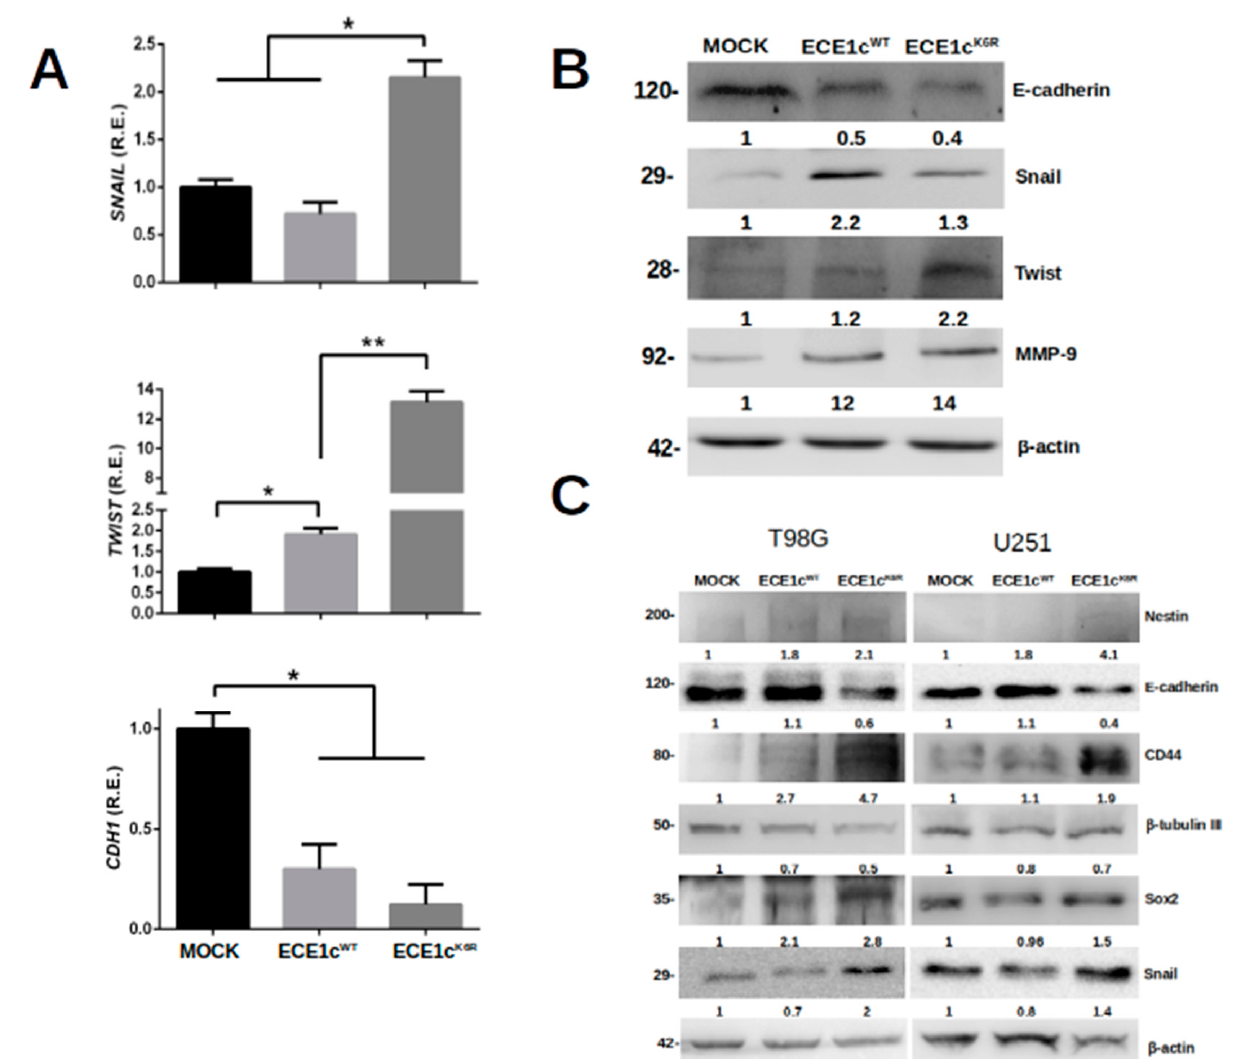
Figure 7. ECE1c K6R overexpression promoted the expression of EMT-linked markers. ( A ) Transcript levels of the EMT markers Snail, Twist, and E-cadherin of mock, ECE1c WT -expressing, and ECE1c K6R - expressing U87MG clone cells grown in normal conditions for 24 h were quantified using RT-qPCR. Data represent averages ± SEMs ( n = 3). Peritz F and Student’s tests were used. * p ≤ 0.05, ** p ≤ 0.01. ( B ) Protein levels of EMT-related markers of cells grown as in A were measured using Western blots with specific antibodies. ( C ) Protein levels of both stemness- and EMT-related markers of mock, ECE1c WT -expressing, and ECE1c K6R -expressing T98G or U251 clone cells grown in normal conditions for 24 h were measured using Western blots with specific antibodies. Representative images from three independent experiments are shown.